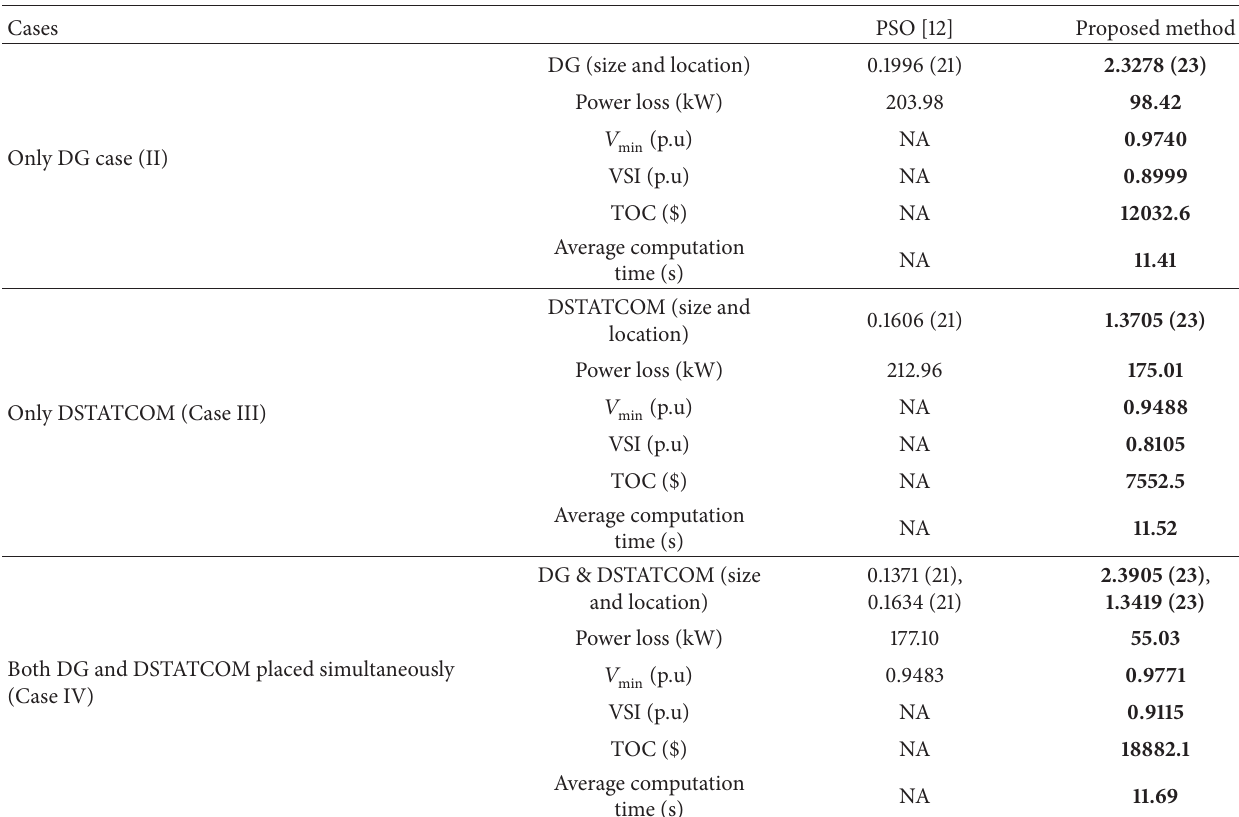
Table 2: Result of 34-bus